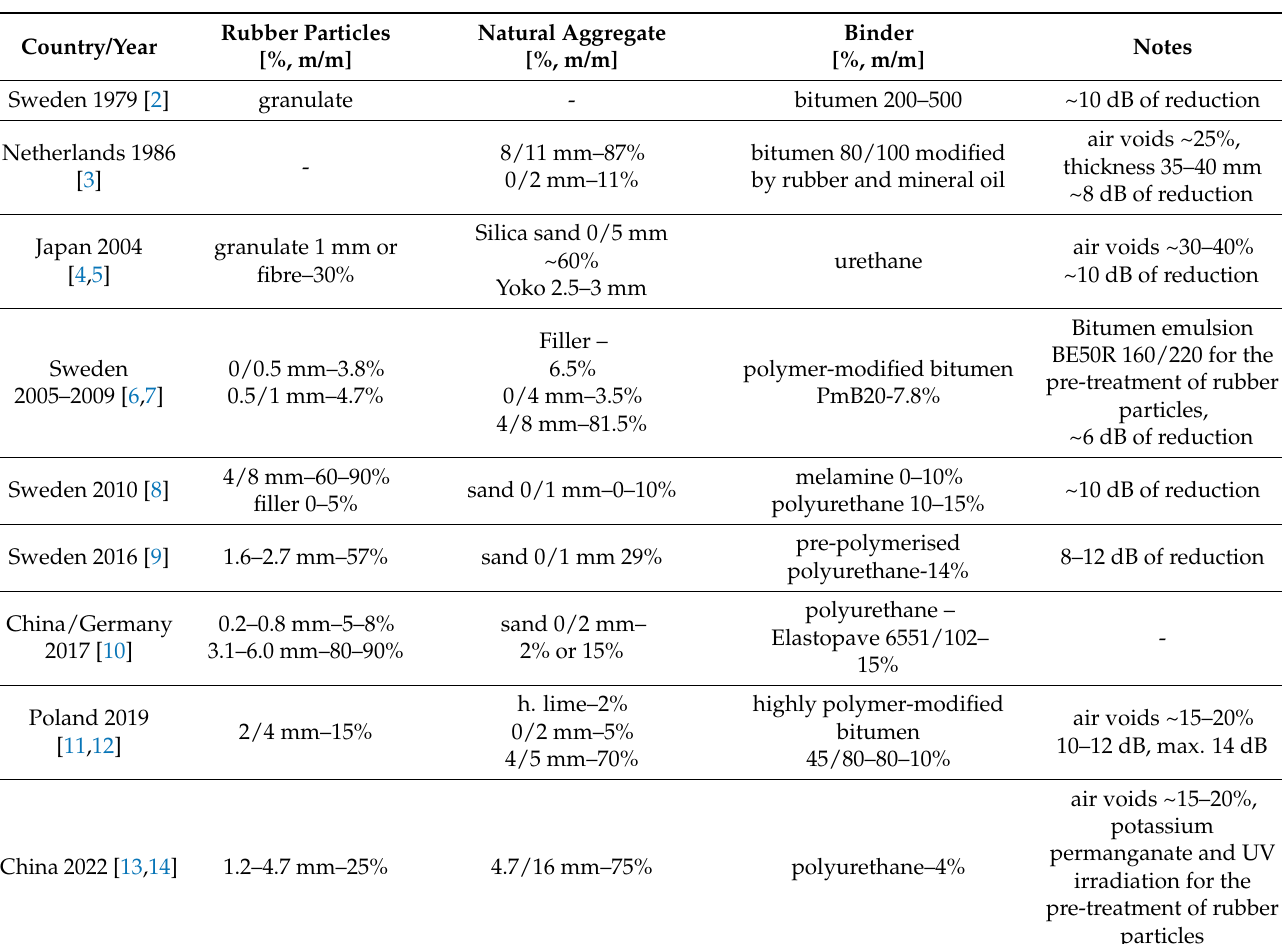
Table 1. Summary of the development of poroelastic